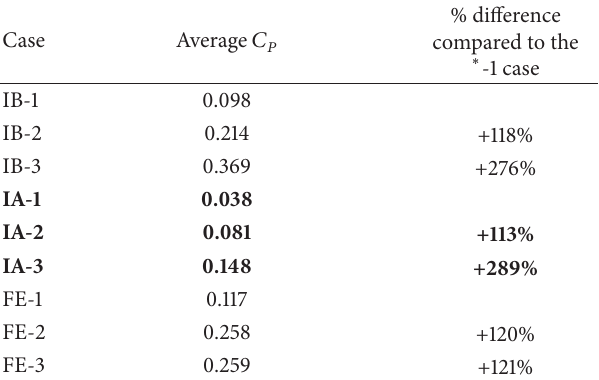
Table 2: Average performance coefficient on one revolution for all the considered cases.